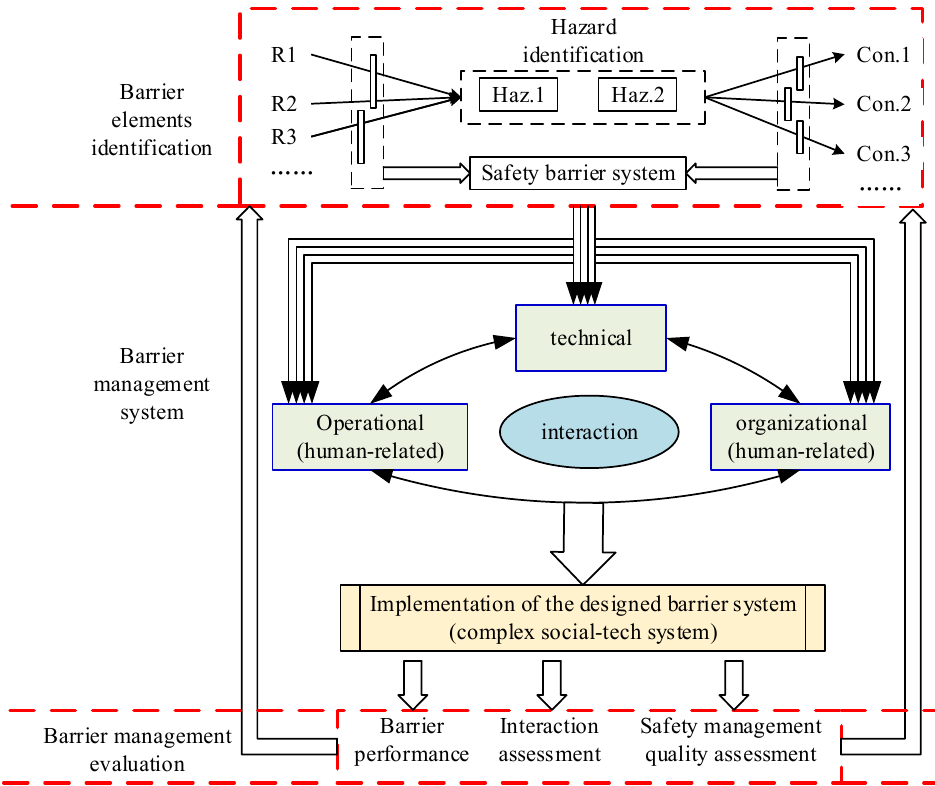
Figure 14. Basic principle of the safety barrier management system. (1) Barrier elements